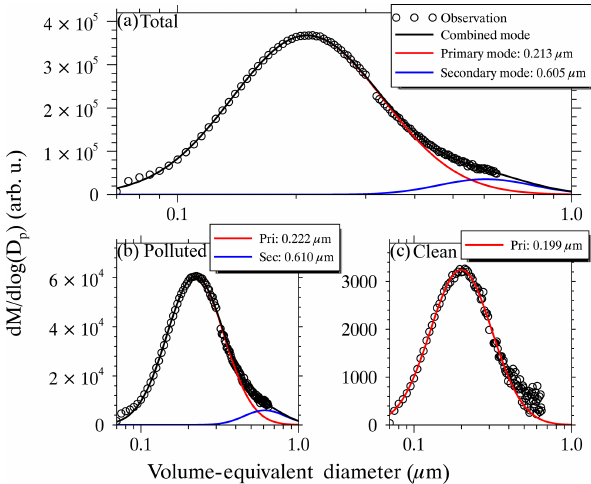
Figure 1. Size distributions of rBC in volume-equivalent diameter during a campaign from 24 February to 15 March, 2014. The red and blue lines are the lognormal fittings to the primary and sec- ondary modes, respectively, and the black ones correspond to the combined